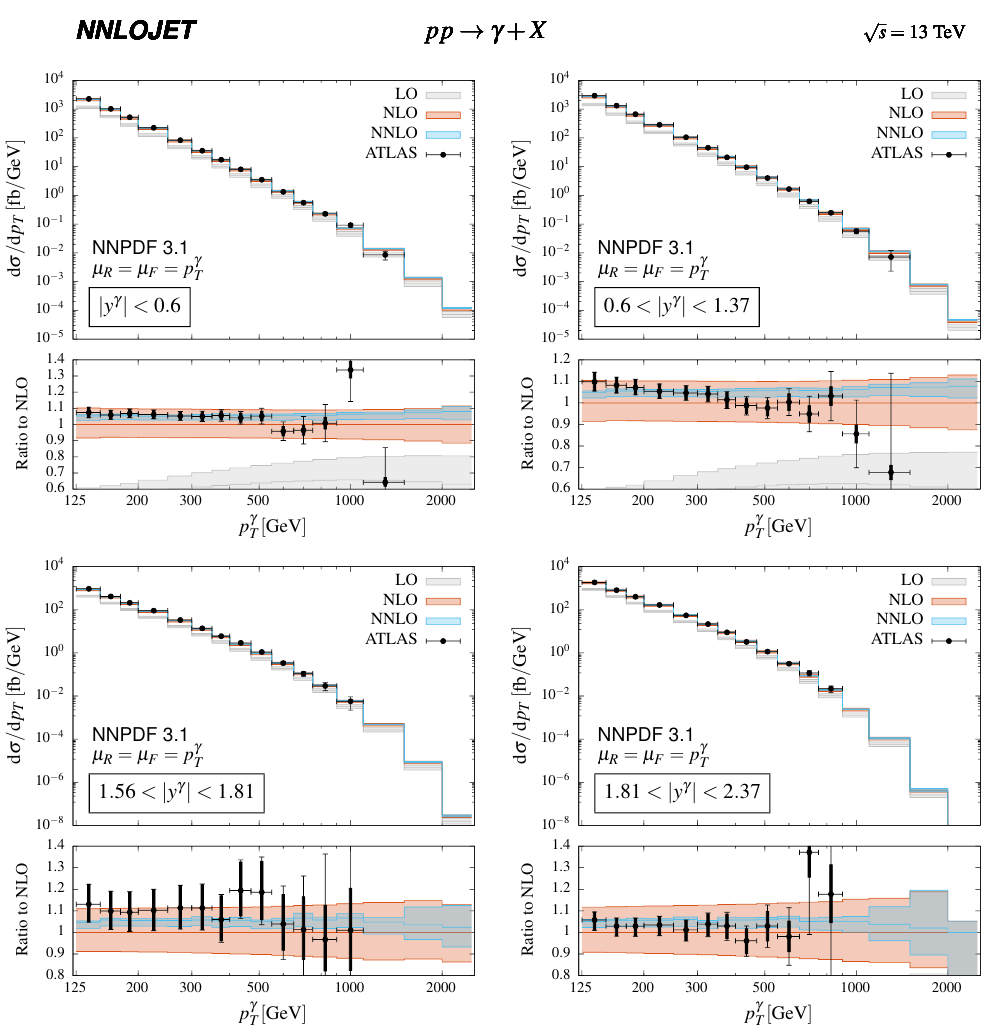
Figure 6 . Transverse energy/momentum distribution of isolated photons at LO, NLO and NNLO in four di(cid:11)erent rapidity bins, from central (top left) to most forward (bottom right). The results are compared to 13 TeV ATLAS data